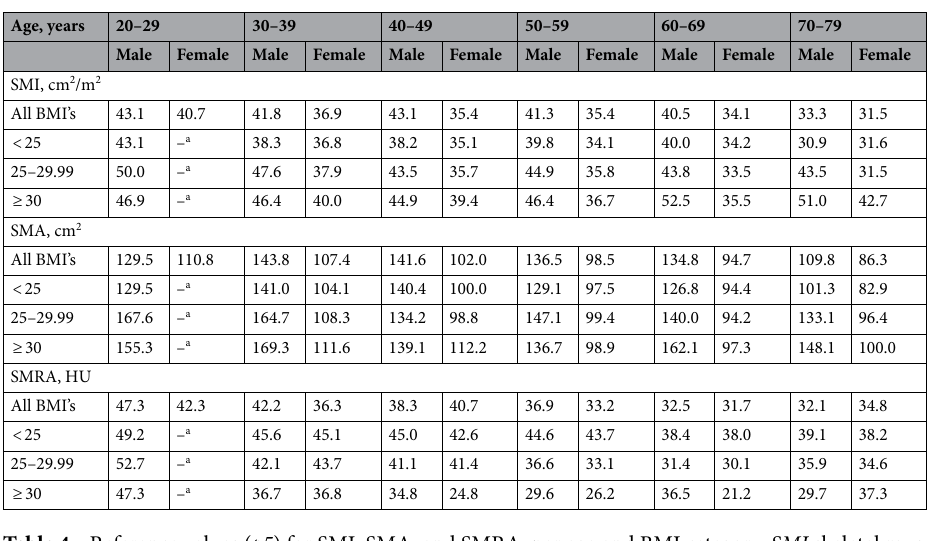
Table 4. Reference values ( p5 ) for SMI, SMA, and SMRA, per age and BMI category. SMI skeletal muscle index (cm 2 /m 2 ), SMA skeletal muscle area (cm 2 ), SMRA skeletal muscle radiation attenuation (HU), BMI body mass index (kg/m 2 ). a Number of donors per BMI category too small to perform analyses. Only reference value for all BMI’s provided.